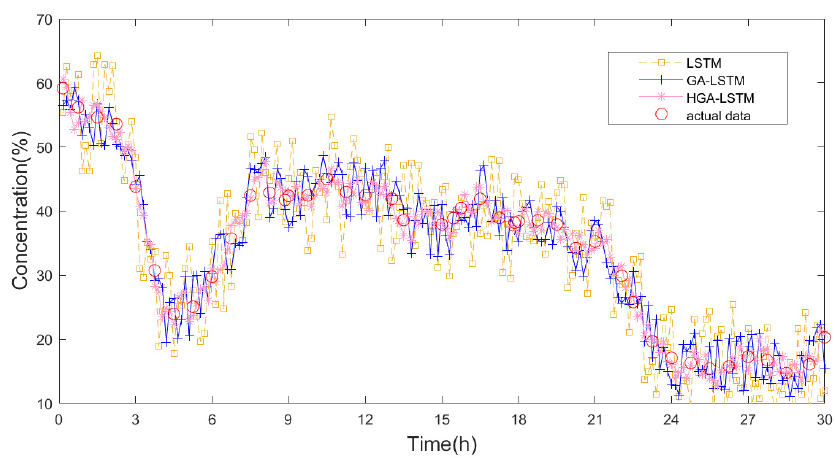
Figure 9. The predicted value of LSTM, GA-LSTM, and HGA-LSTM.